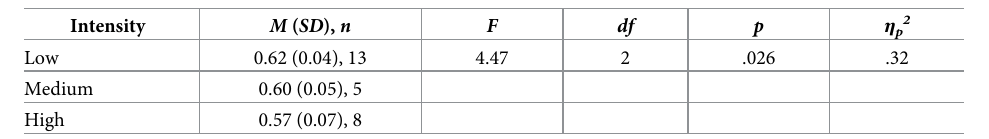
Table 3. Parent training intensity and functional anisotropy in the forceps